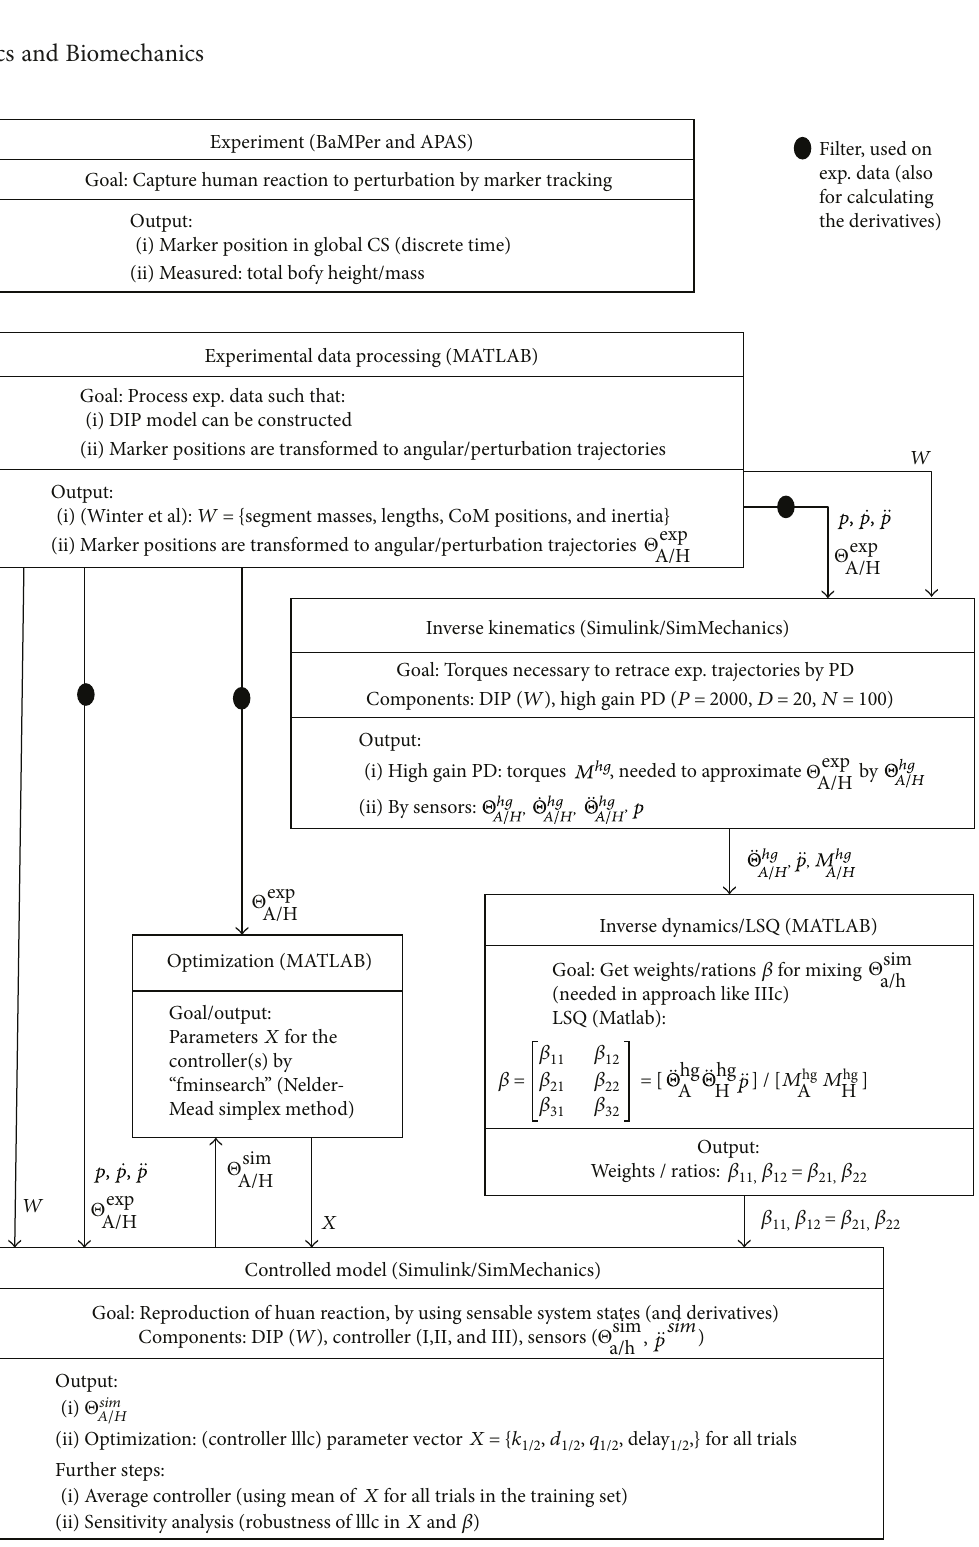
Figure 2: Data and work fl ow of the project. This sketch illustrates what was done, in which order and with the help of which tools. Large subscript A/Hare usedif the trajectoryis meant,andsmall subscript a/hare used if onlyonevalue (e.g., sensorsignals at a certain pointin